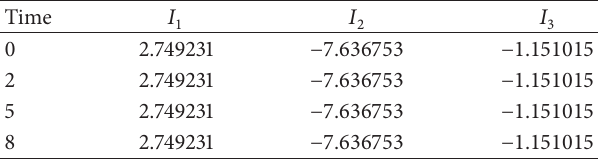
Table 4: Conservative quantities.